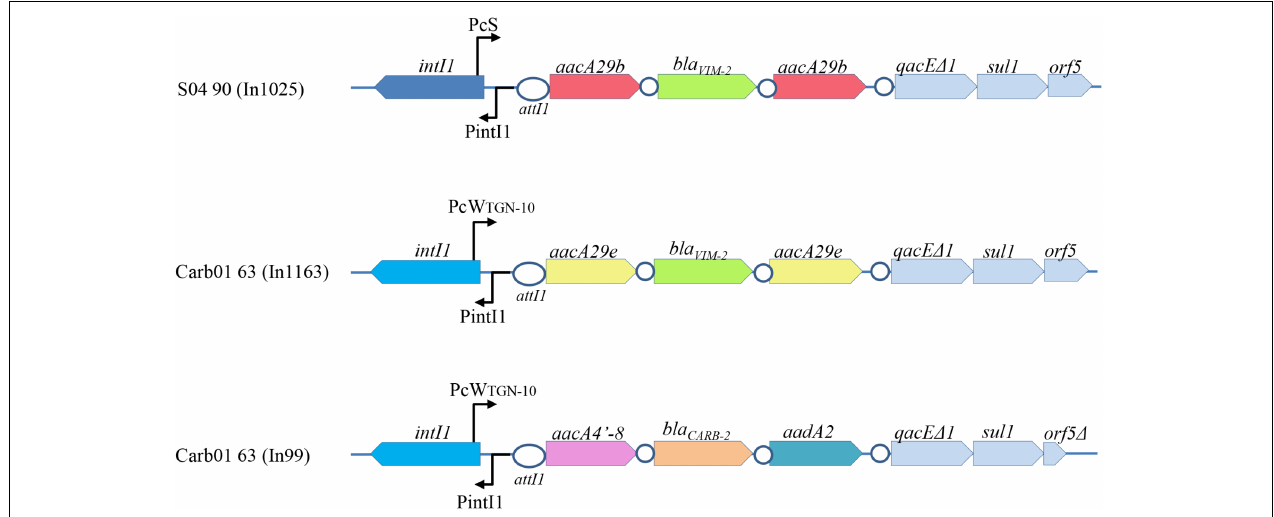
FIGURE 1 | Schematic representation of the integrons of Carb01 63 and S04 90. The gene cassette promoters (Pc) are different. PcS represents a strong promoter, whereas PcW TGN − 10 represents a promoter that is considerably weaker due to nucleotide substitutions in the –10 and –35 regions, which are, however, partially compensated by a C to G substitution upstream of the –10 region, resulting in an extended –10 motif (Jové et al., 2010). These differences also affect the primary structures of the integrases encoded by the intI1 genes (dark and bright blue). Cassettes with the same nucleotide sequences are indicated with the same color. No differences were observed in the 3 (cid:48) conserved sequences, except that orf5 in In99 is truncated. The integration sites attI1 and attC are indicated by ovals and circles,